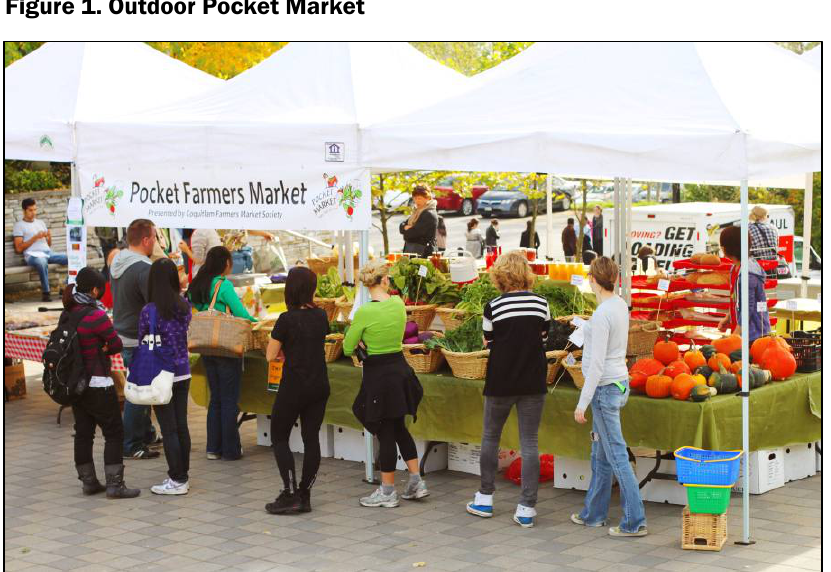
Figure 1. Outdoor Pocket